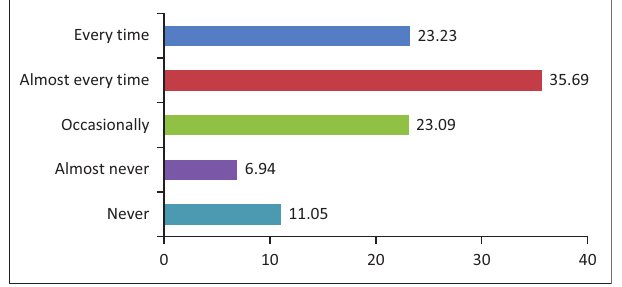
FIGURE 7: Compliance with established legislative parameters in completing a task.